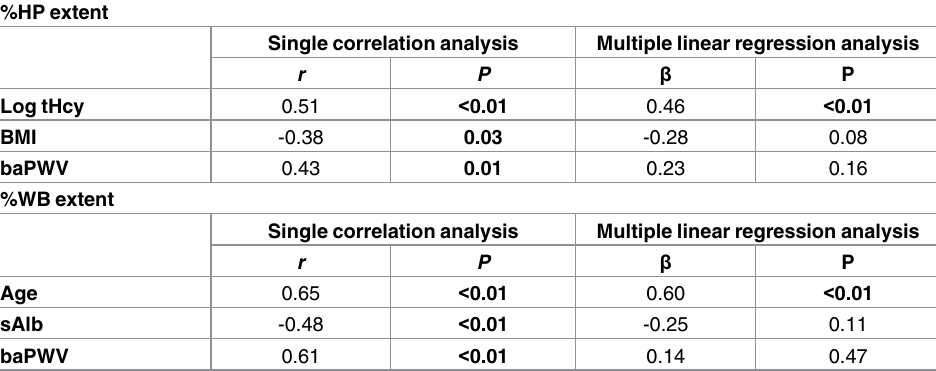
%HP extent was related to high log tHcy level. On the other hand, %WB extent was related to high age,